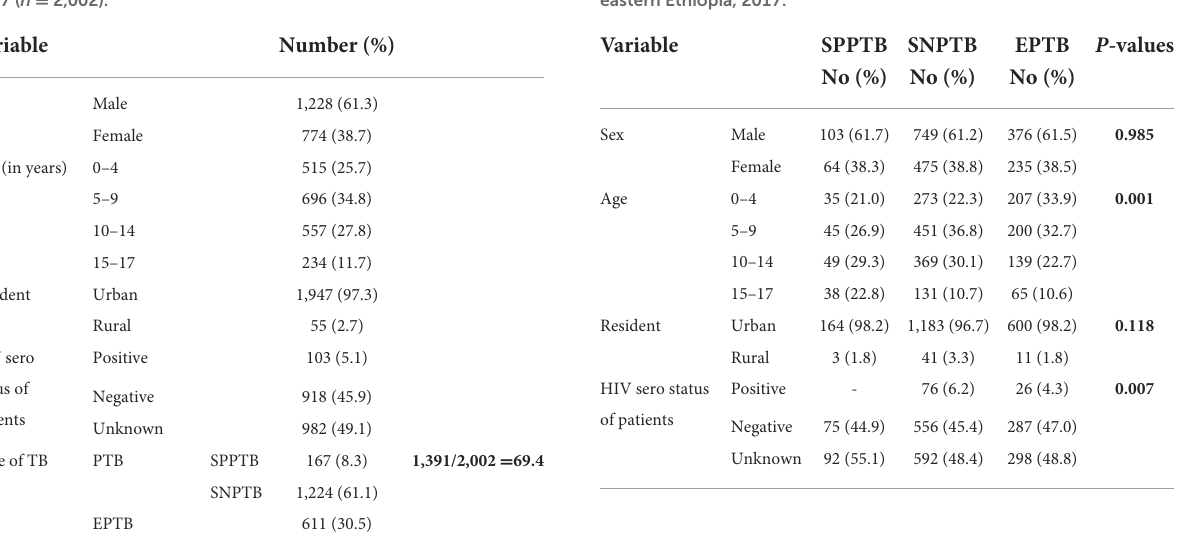
TABLE 1 Sociodemographic characteristics of children TB patients attending treatment in selected health institutions of eastern Ethiopia, 2017 ( n = 2,002).